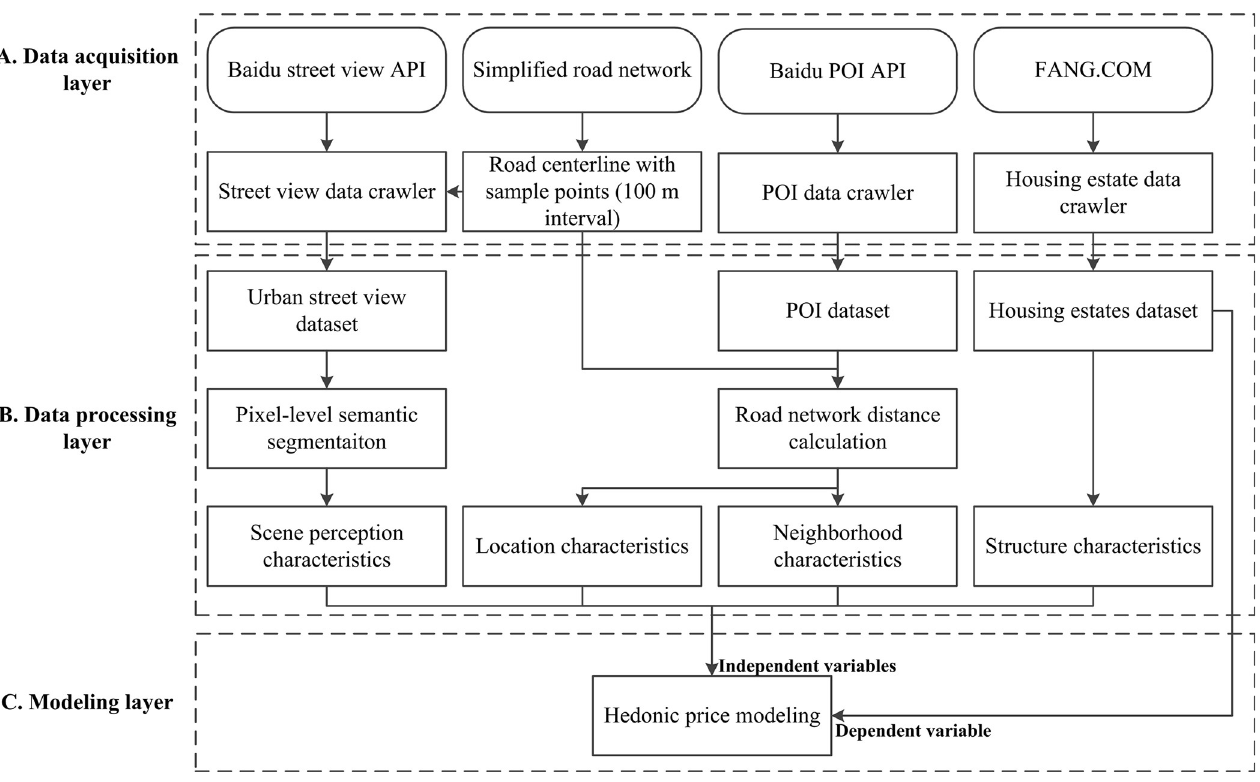
Fig 2. The open-access-dataset-based hedonic price modeling (OADB-HPM) framework.